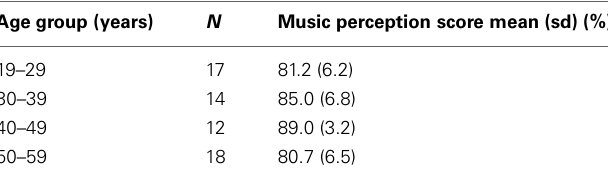
Table 6 | Average music perception scores of the age